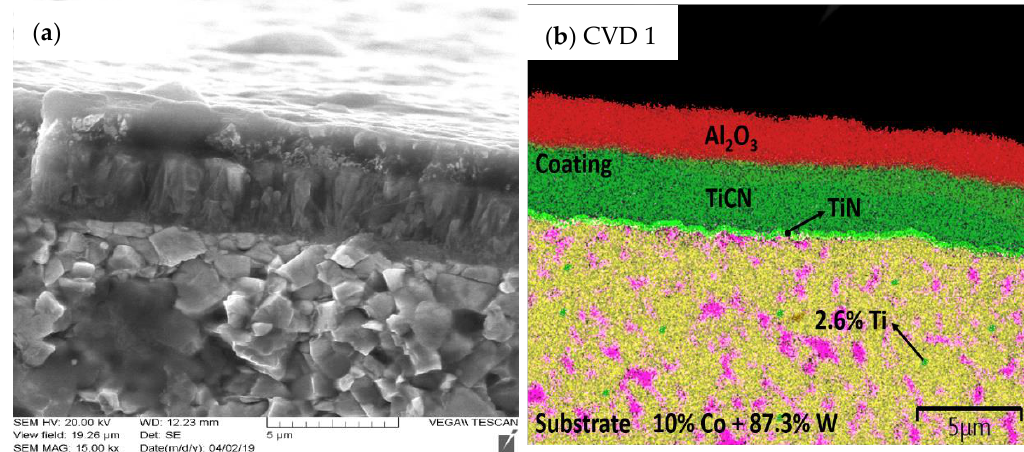
Figure 2. Fracture section of the studied CVD coating: ( a ) SEM image; ( b ) EDS data (weight %): Al—red; Ti—green; W—yellow; Co—pink color.